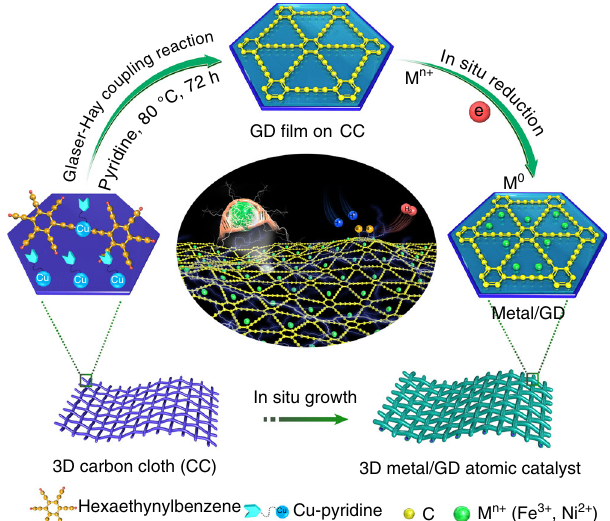
Fig. 1 Protocols for the synthesis of Ni/GD and Fe/GD. A two-step strategy for anchoring-isolated Ni/Fe atoms on GD, including the in situ growth of GD layers on 3D carbon cloth (CC) surfaces via Glaser-Hay cross-coupling reaction, followed by the electrochemical reduction of metal ions (Ni 2 + and Fe 3 + ) into zerovalent metallic species [Ni(0) and Fe(0),